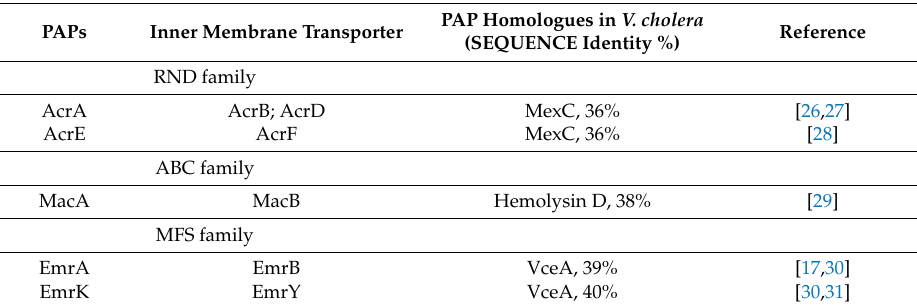
Table 1. E. coli PAP homologues in V. cholerae